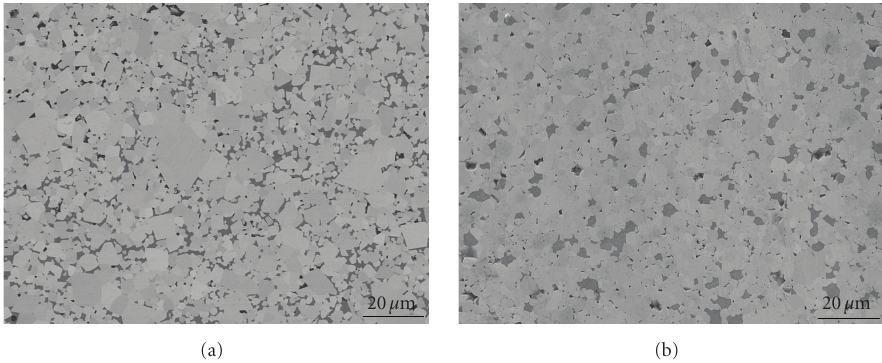
Figure 5: SEM micrographs of the polished surface of (a) HC10 and (b) HC10 ∗ (ultrasonicated). The bright grains are HfC, and the dark phase is MoSi 2 . Note the change in the matrix morphology and size after the ultrasonication step in (b).